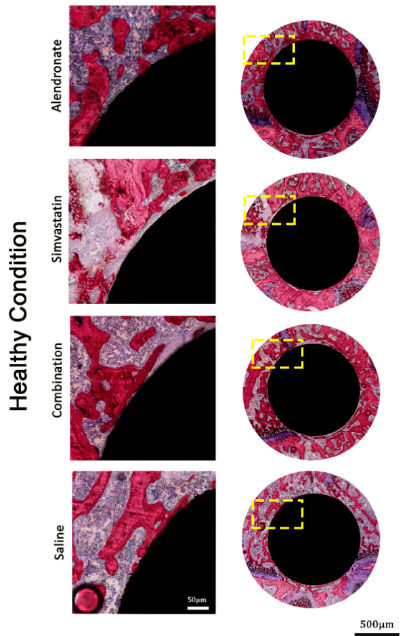
Figure 3. Representative histological images stained with methylene blue and basic fuchsin, showing non-decalcified (pMMA embedded) cross-sections in osteoporotic bone conditions. Appl. Sci. 2020 , 10 , x FOR PEER REVIEW